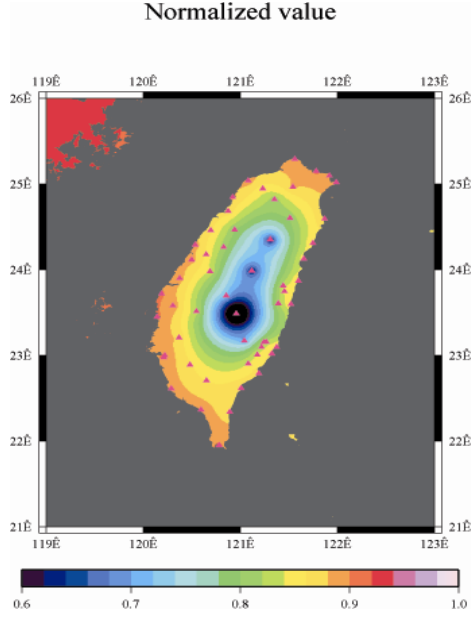
Figure 17. Normalized ZTD values around the island before plum rains (June 2nd, 2008, 5:00